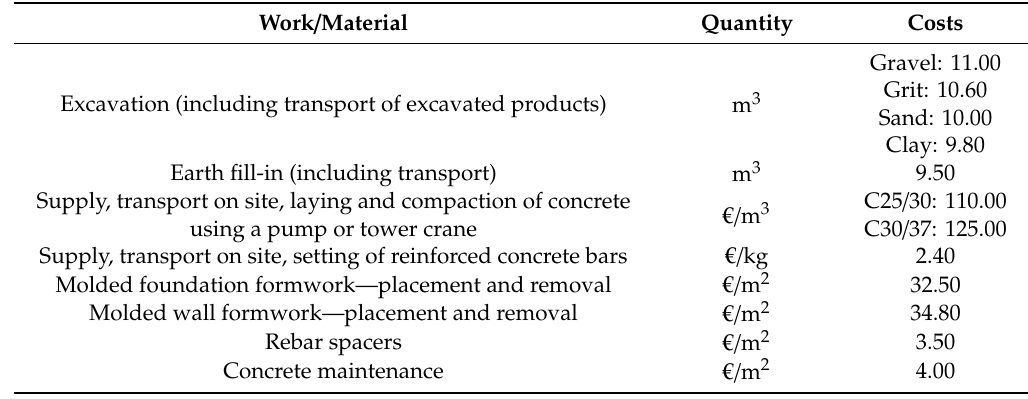
Table 2. Material / labor costs for reinforced concrete retaining